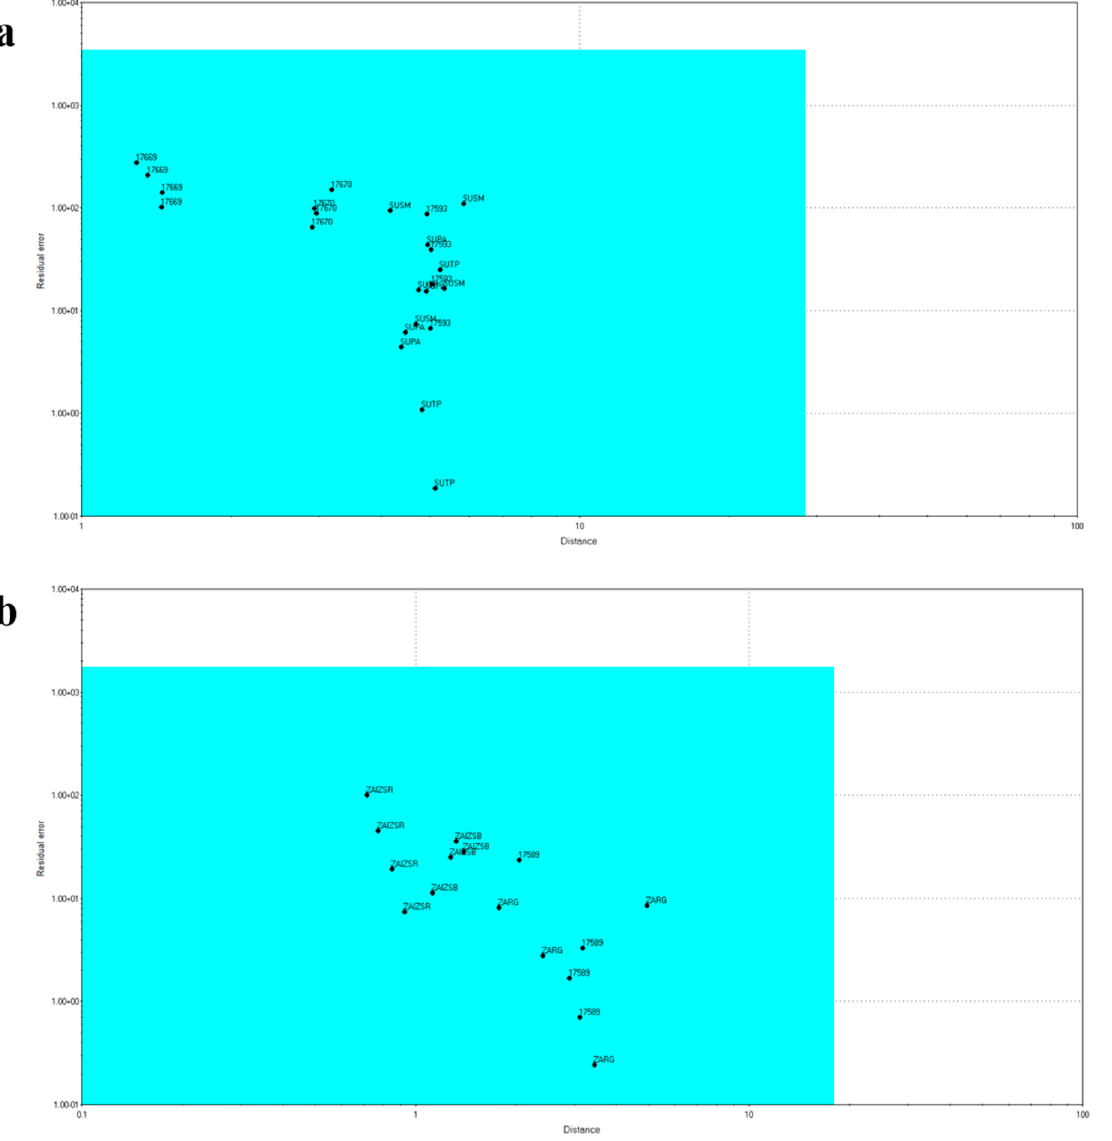
Figure 5. SIMCA model for ( a ) Sulla honeys and ( b ) Citrus honeys.